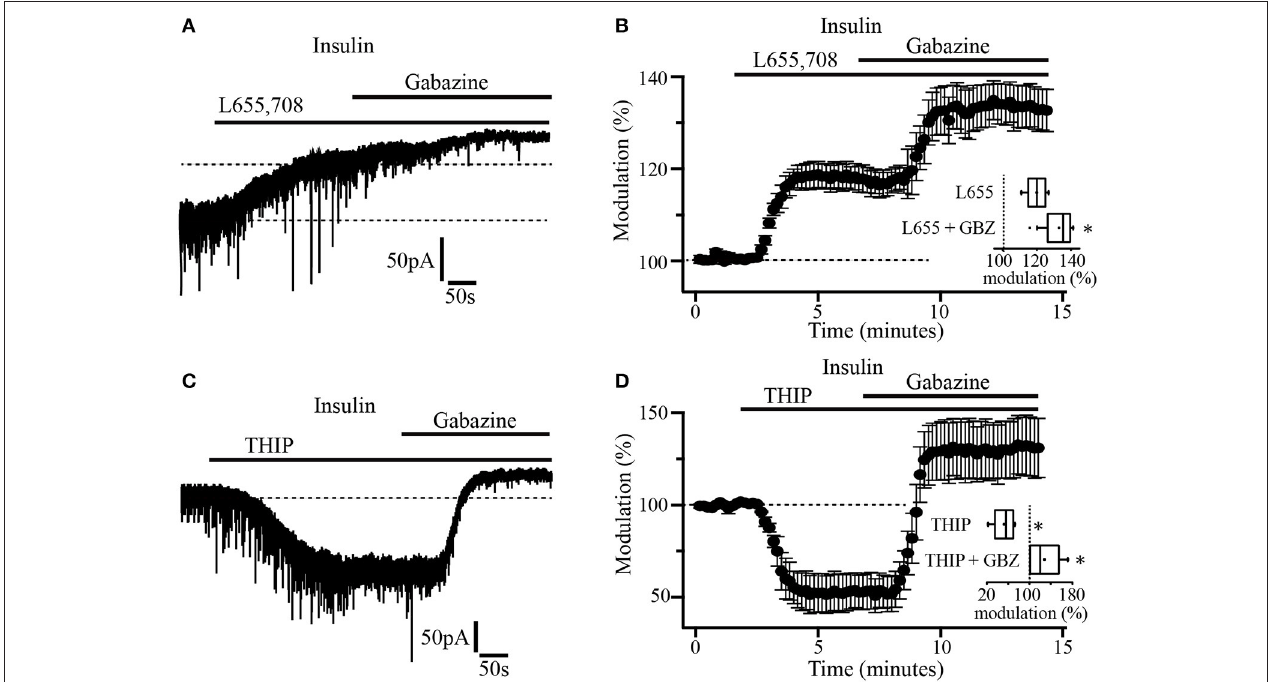
FIGURE 3 | Insulin-sensitive tonic current is mediated by α 5 and δ subunit-containing GABA A receptors. (A) The α 5 inverse agonist, L-655, 708 antagonizes GABA A receptor-mediated tonic current in pyramidal neurons. Note that gabazine application caused an additional shift of the tonic current (upper dash line). (B) Shift of the tonic current by L-655, 708 and the subsequent application of gabazine expressed as percentage of the basal level ( n = 7). The inset shows a box plot comparing L-655, 708 with L-655, 708 plus gabazine (GBZ). (C) THIP (5 µ M) an agonist for δ subunit-containing GABA A receptors, induces a downward shift in the holding current which is then blocked by gabazine application. (D) Shift of the tonic current by THIP and gabazine application expressed as percentage of the basal level ( n = 5). The inset shows a box plot summary of the results. These experiments were performed in slices incubated with insulin (20nM) * p <